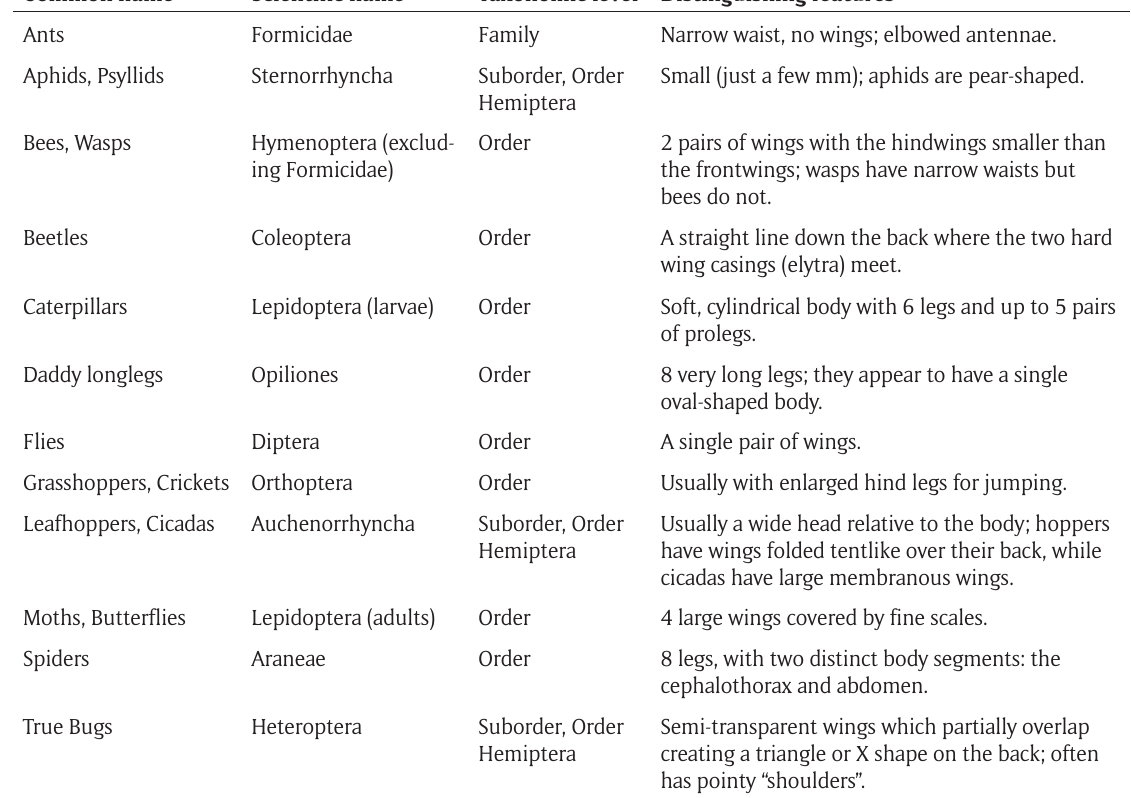
Table 1: Common arthropod groups found on foliage that citizen scientist participants are expected to be able to